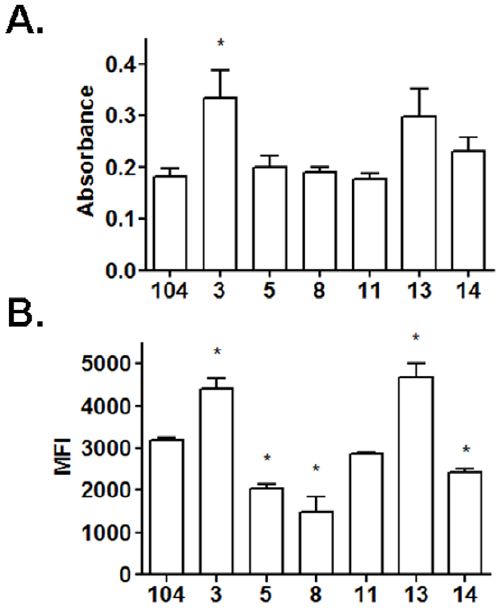
Figure 5. Detection of ManLAM on the bacterial surface. A. M. avium spp. isolates (2 6 10 6 /well) in a 96 well plate (triplicate wells per test group) were blocked with BSA and incubated for 2 h with CS-35 mAb followed by a secondary HRP-Ab. The graph shows cumulative data of N=3 for selected samples (mean 6 SEM; *P , 0.05). See table 4 for the complete set. B. Live bacilli single cell suspensions (1 6 10 6 ) were blocked with 2% BSA in PBS, washed with PBS followed by staining with anti-LAM CS-35 in 2% BSA in PBS for 20 min at 4C. After further washing, samples were analyzed by flow cytometry. Mean fluorescence intensity (MFI) was measured for each isolate and the average values of 2 samples were obtained. Shown is cumulative data of N=2 (mean 6- SEM). *P ,